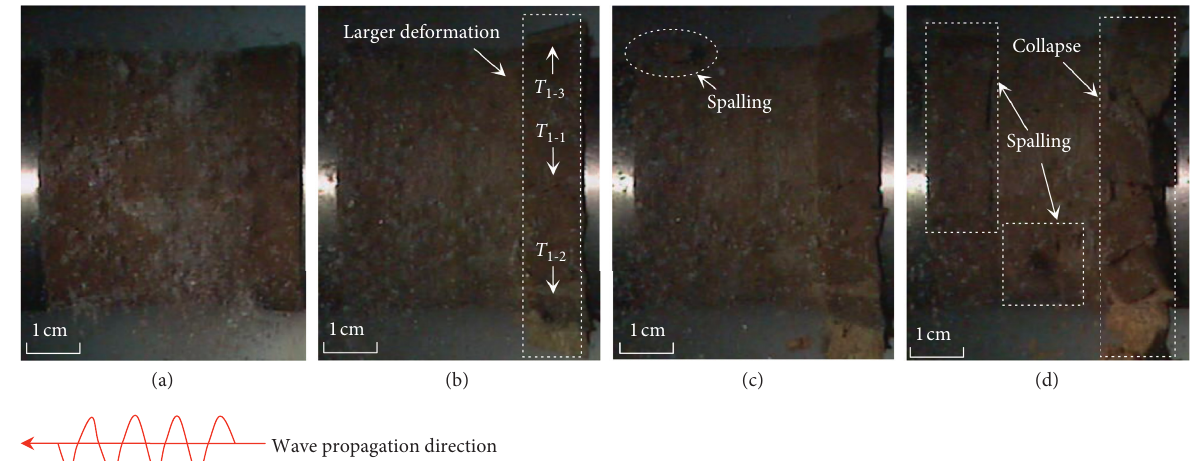
Figure 12: Fracture processes of frozen silty soil specimen with three prefabricated